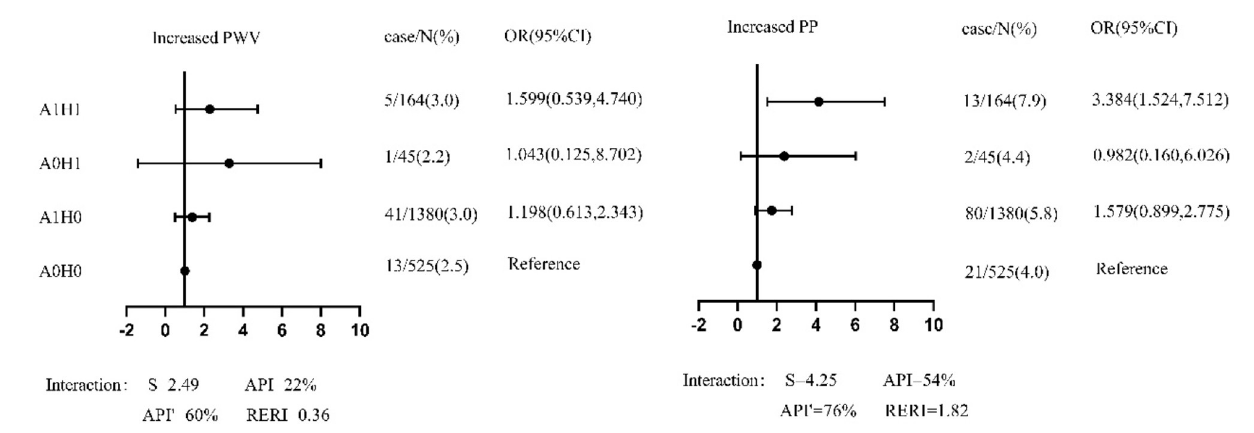
FIGURE 2 | The forest plot of association between groups of different hyperfiltration and metabolic status and outcomes among participants with ABI ≥ 0.9 in sensitivity analysis. PP, pulse pressure; baPWV, brachial–ankle pulse wave velocity; S, the synergy index; API, attributable proportion of interaction. API’, pure attributable proportion of interaction; RERI, the relative excess risk due to interaction; A0/A1, normal metabolism/abnormal metabolism; H0/H1, normal filtration/hyperfiltration. OR (odds ratio) and 95% CI (confidence interval) were from multivariate logistic regression, in which sex, age, current smoking, current drinking, BMI, HR at baseline and new onset hypertension, diabetes, dyslipidemia, overweight/obesity during follow-up were adjusted.